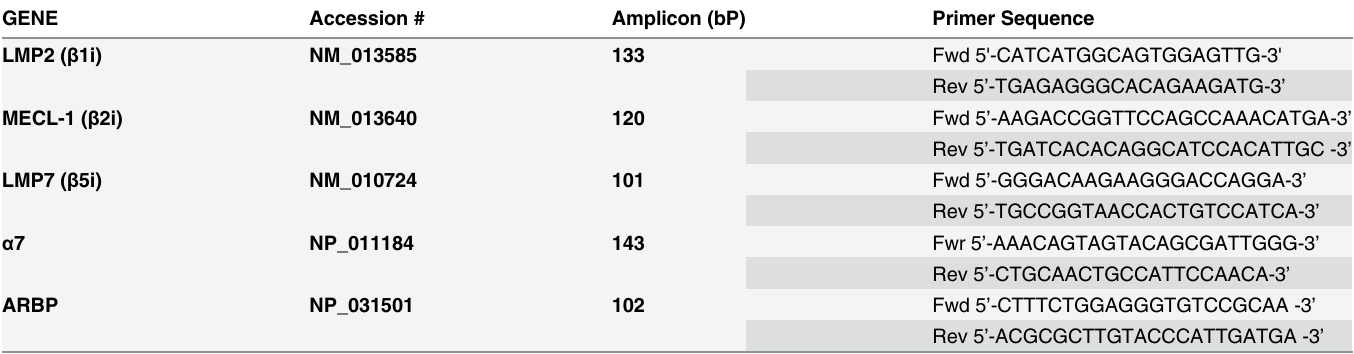
Table 2. Primers used for